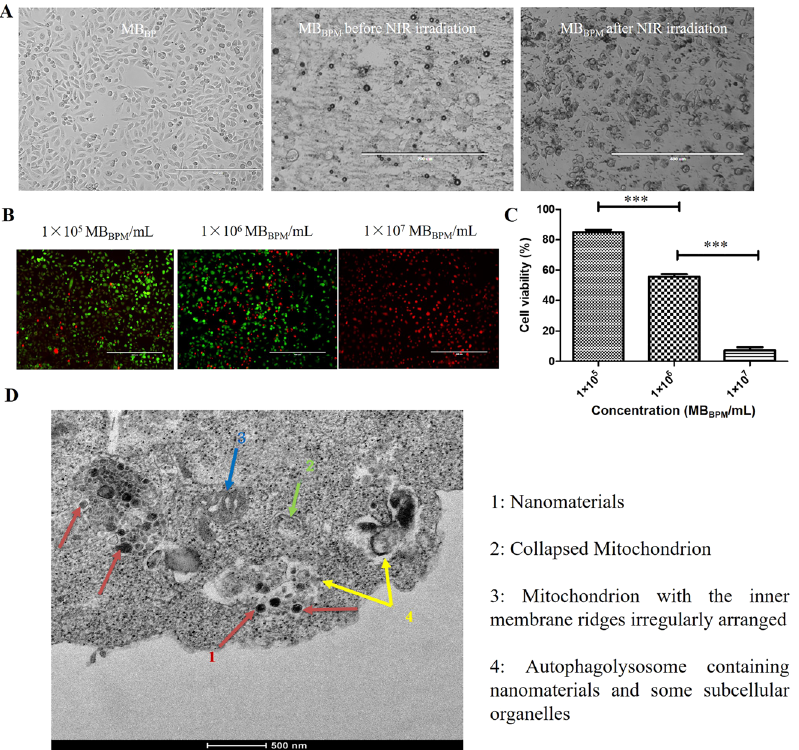
Figure 9: (A) The optical images of MCF-7 cancer cells incubated with MB BP and MB BPM under the magnetic fi eld ( B ≈ 1.2 T) for 3 min and then under the NIR laser irradiation. (B) The fl uorescence images of the treated MCF-7 cancer cells stained with calcein AM (green) and PI (red) for liveanddeadcells,respectively.(C)ThecorrespondingrelativeviabilityoftheMCF-7cancercellstreatedwithdifferentconcentrationofMB BPM under the 808 nm laser irradiation (2.0 W/cm 2 ) for 10 min. (D) The TEM image of the MCF-7 cancer cells incubated with MB BPM (1 × 10 7 MB BPM / mL) under the magnetic fi eld ( B ≈ 1.2 T) for 3 min and then treated under the 808 nm laser irradiation (2.0 W/cm 2 ) for 10 min. 1: the nanomaterials uptaken inside the MCF-7 cells indicated by the red arrows; 2 and 3: the mitochondrion already collapsed and with the inner membraneridgesirregularlyarrangedindicatedbythegreenandbluearrows,respectively.4:Autophagolysosomecontainingnanomaterials and some subcellular indicated by the yellow arrows. The scale bar in the optical images of MCF-7 cancer cells incubation with MB BP